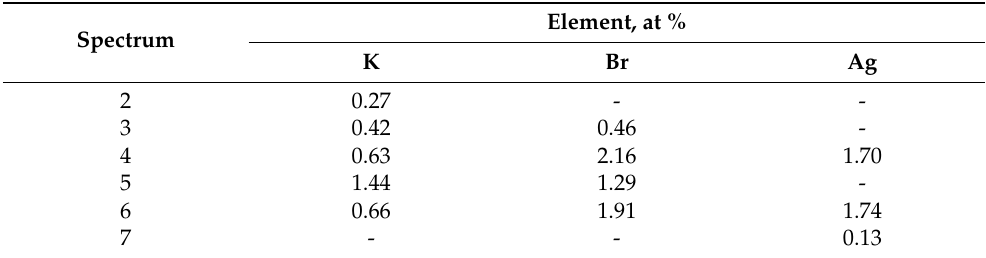
Table 1. EDX cross-section element (except for Si, O) atomic concentration (at %) of the Ag/AgBr/MAP